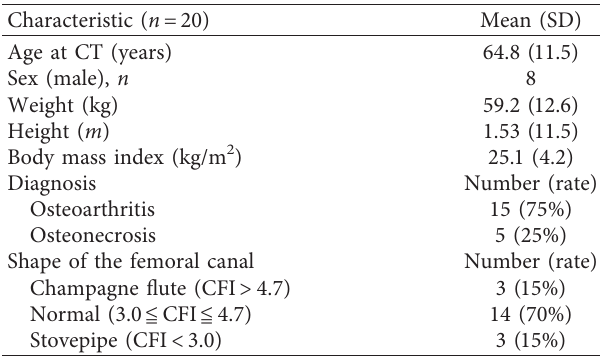
Table 1: Demographics of all patients for the postoperative